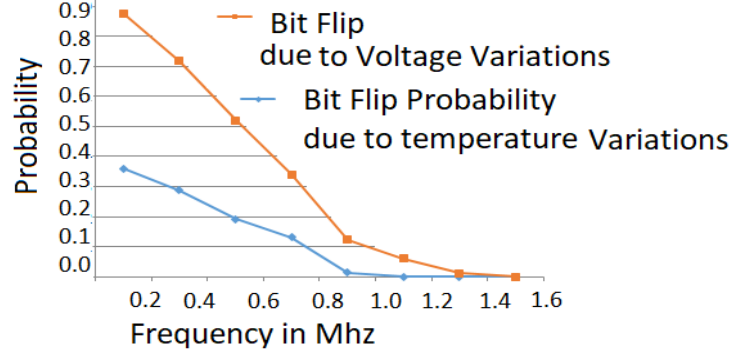
Figure 10. Reliable frequency difference threshold.